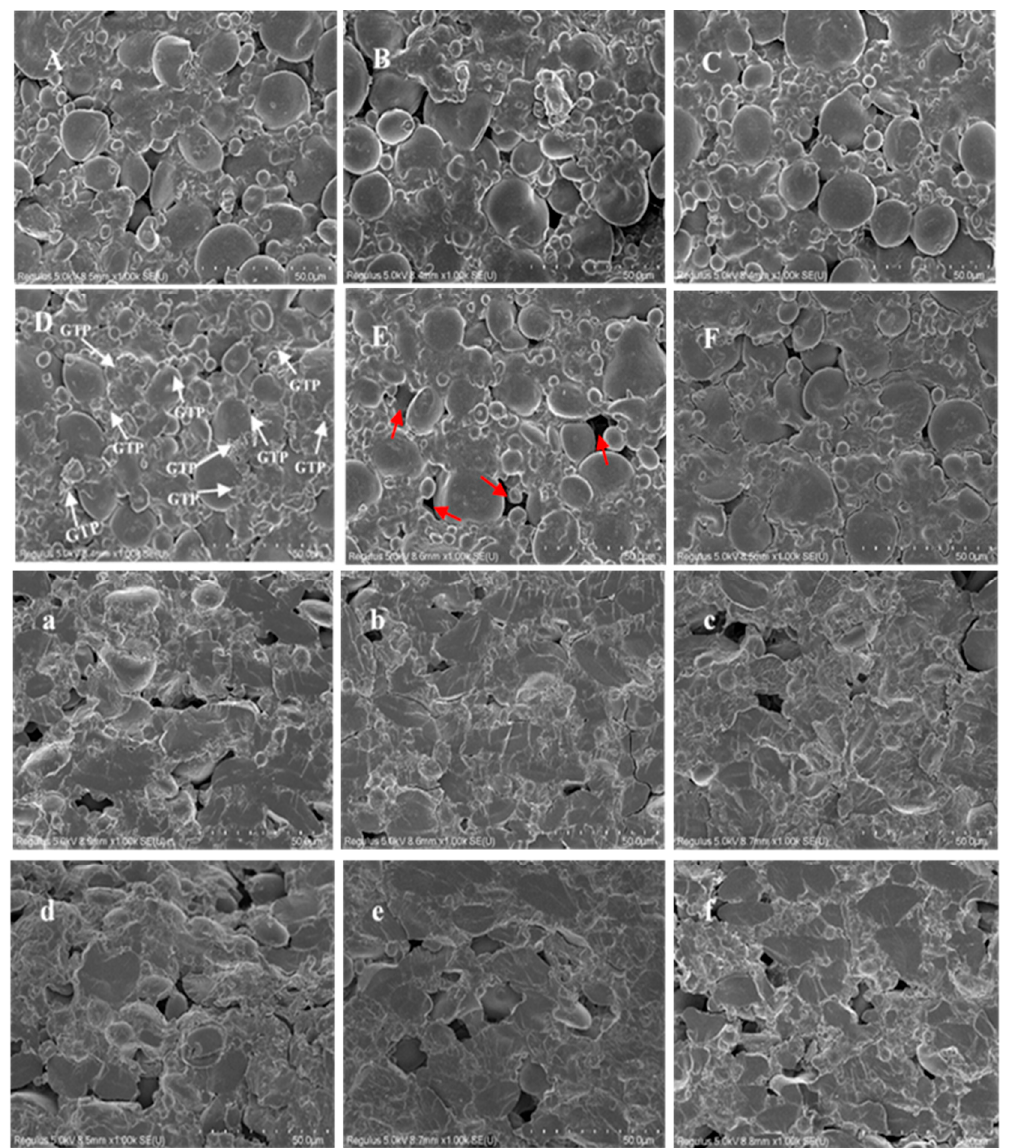
Figure 3. Scanning electron micrographs of DGTN with different particle sizes or concentrations GTP (( A – F ) represent surface pictures of 0.5% DGTN 1, 0.5% DGTN 2, 0.5% DGTN 3, 2% DGTN 1, 2% DGTN 2, and 2% DGTN 3, respectively; ( a – f ) represent cross-sections of 0.5% DGTN 1, 0.5% DGTN 2, 0.5% DGTN 3, 2% DGTN 1, 2% DGTN 2, and 2% DGTN 3, respectively).